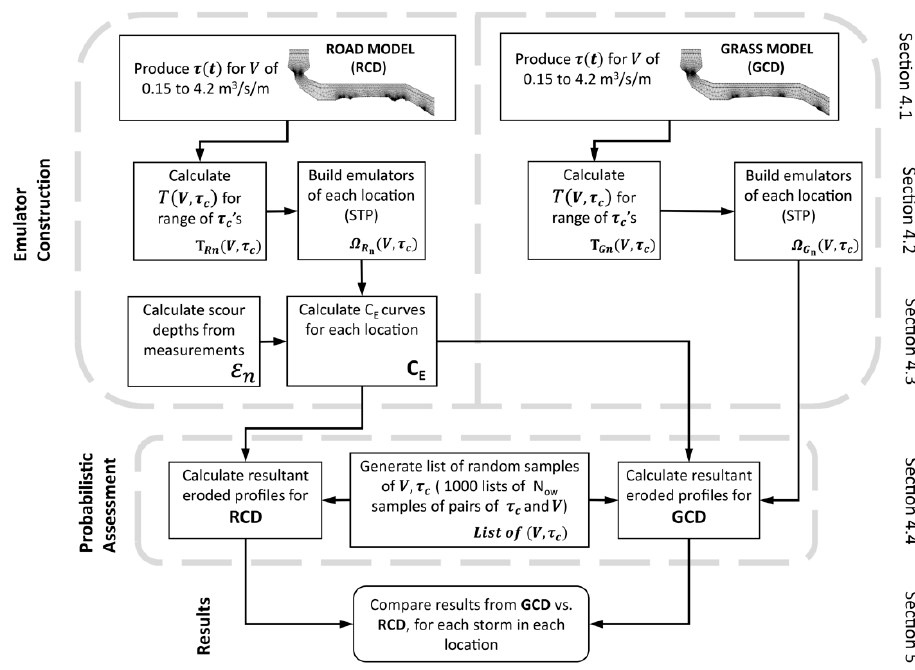
Figure 3. Flow chart of the steps of the proposed methodology.